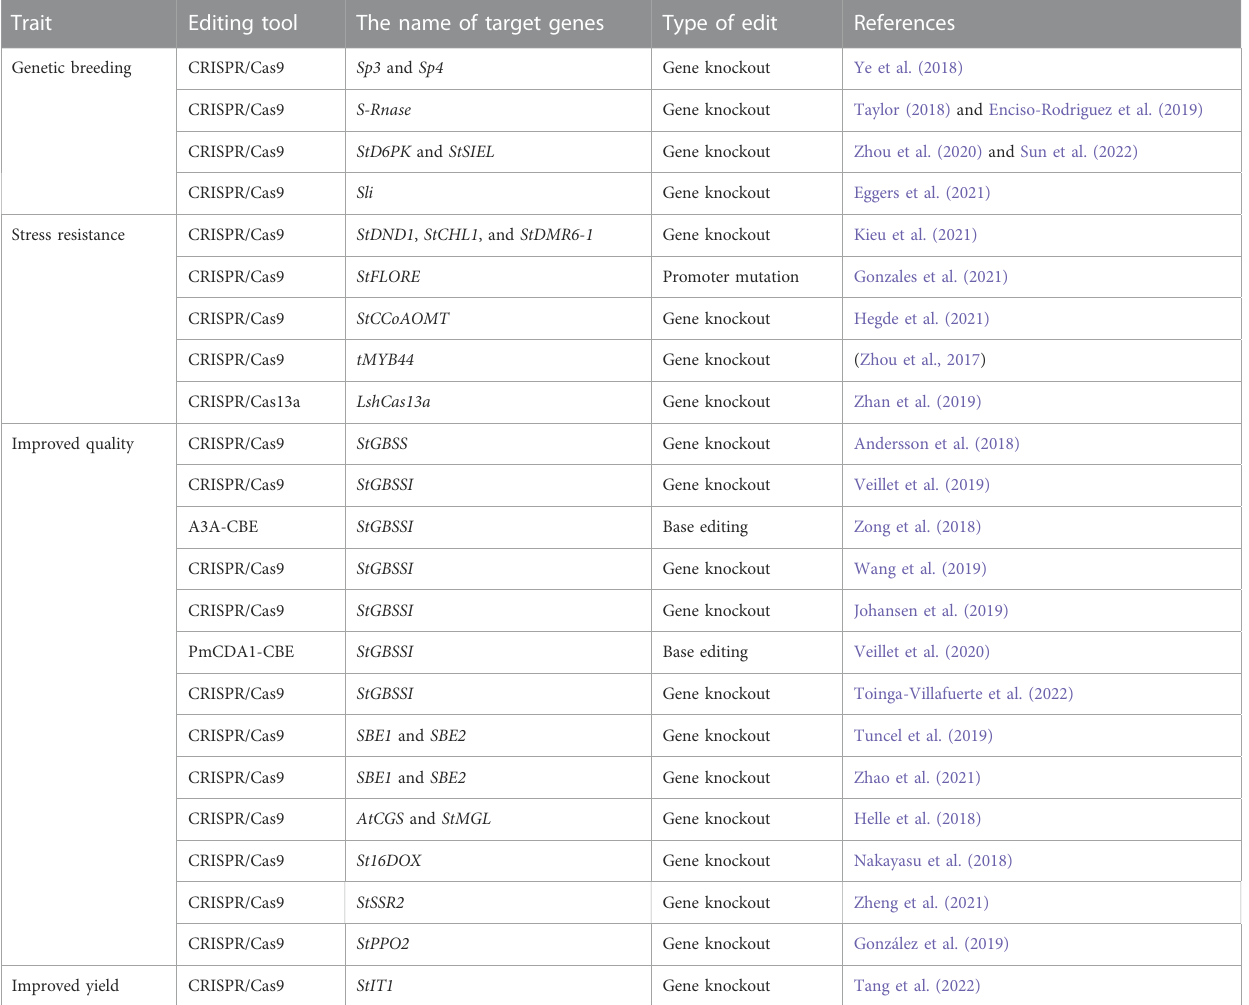
TABLE 1 Applications of CRISPR/Cas system-mediated genome editing technology in potato improvement.